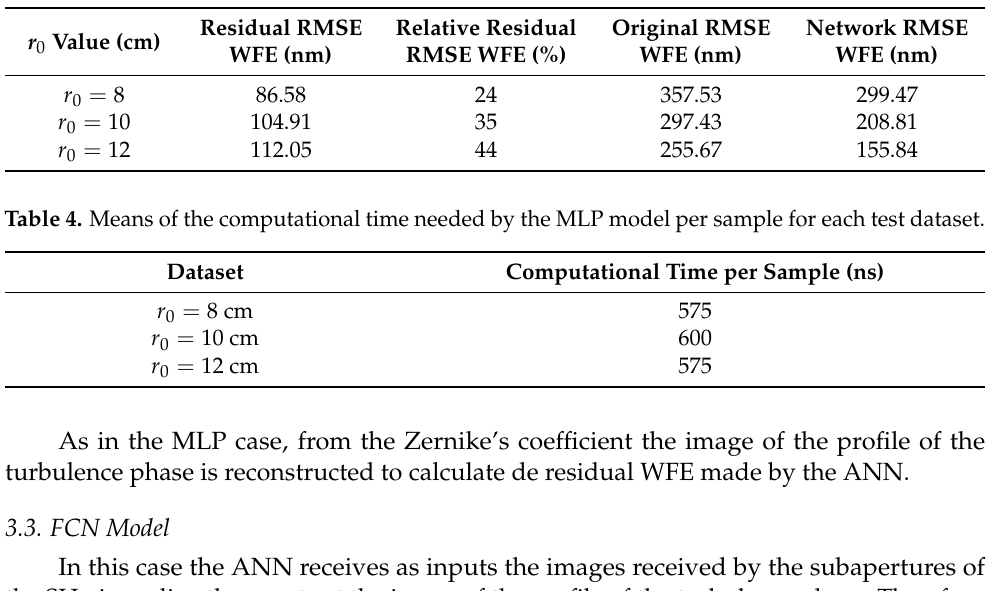
Table 3. Results obtained for the CNN model. Each value is obtained as the mean value over the 3000 samples of the test dataset.